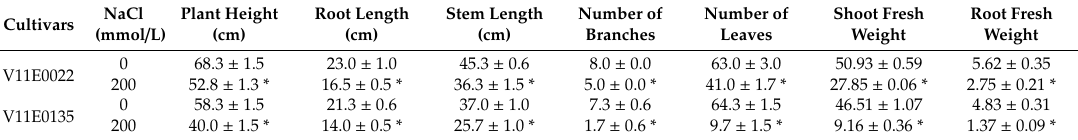
Table 1. E ff ect of salt stress on phenotypic parameters and biomass of two cultivars of the water dropwort. Cultivars